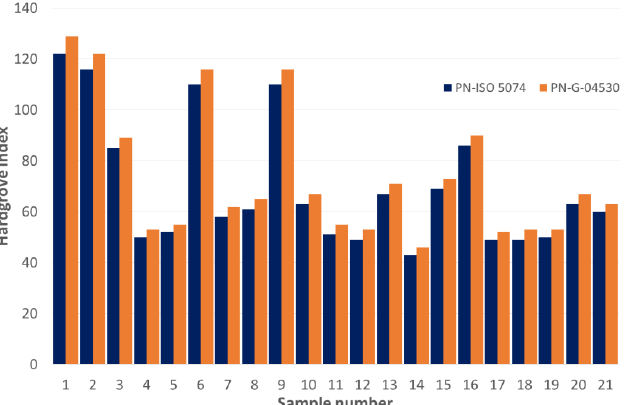
Figure 3. Comparison of Hardgrove index values calculated based on PN-ISO 5074 and PN-G-04530 standards.